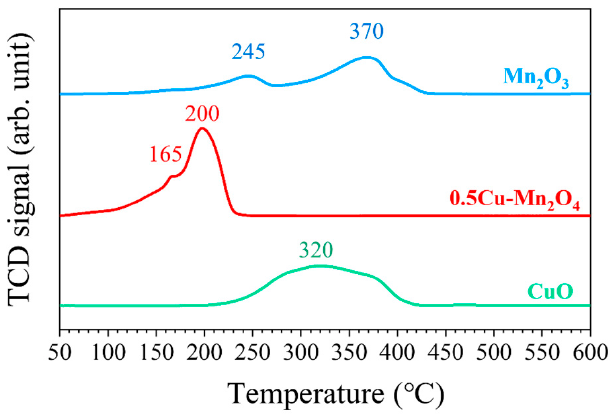
Figure 7. H 2 -TPR Figure 7. H 2 -TPR pro fi les.